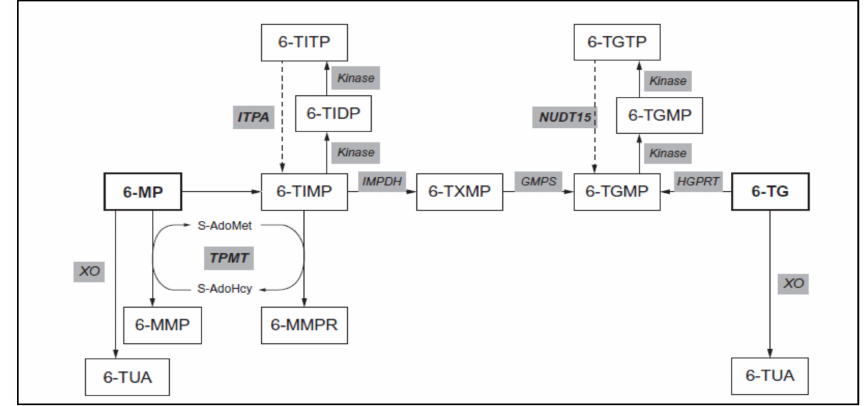
Figure 1. Detailed 6-mercaptopurine metabolic pathways presenting the enzymes